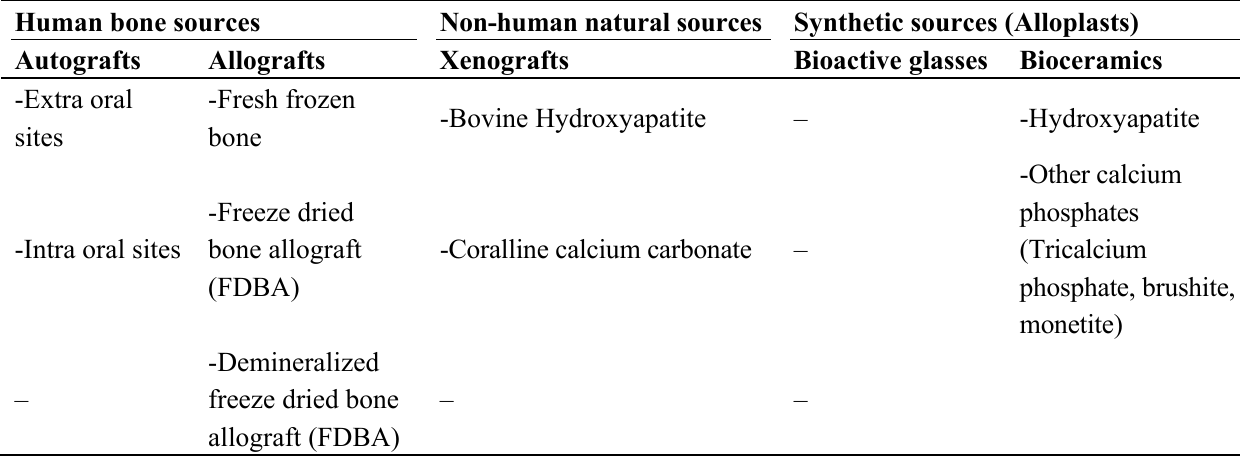
Table 1. Bone replacement graft tissues and materials.